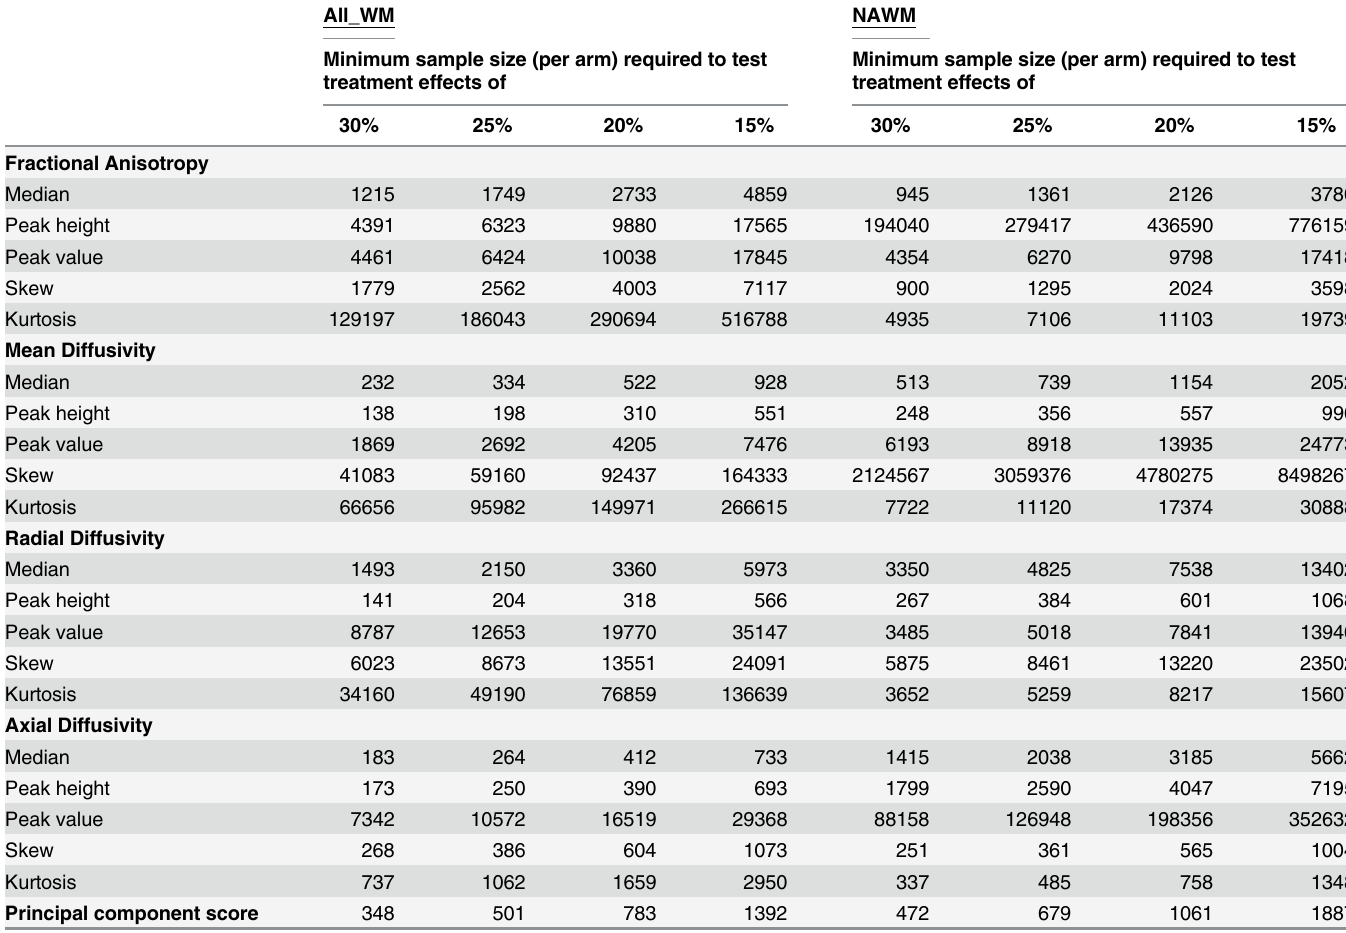
Table 3. The minimum sample size estimation per arm required to test treatment effects of various percentages using DTI parameters. All_WM